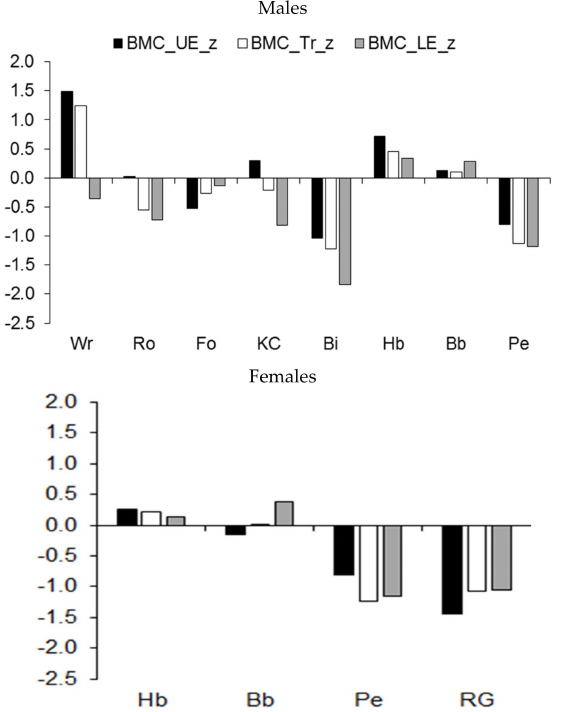
Figure 4. Median z-scores of BMC (expressed as a percentage of stature) of the upper extremities (UE), trunk (Tr), and lower extremities (LE) in youth athletes by